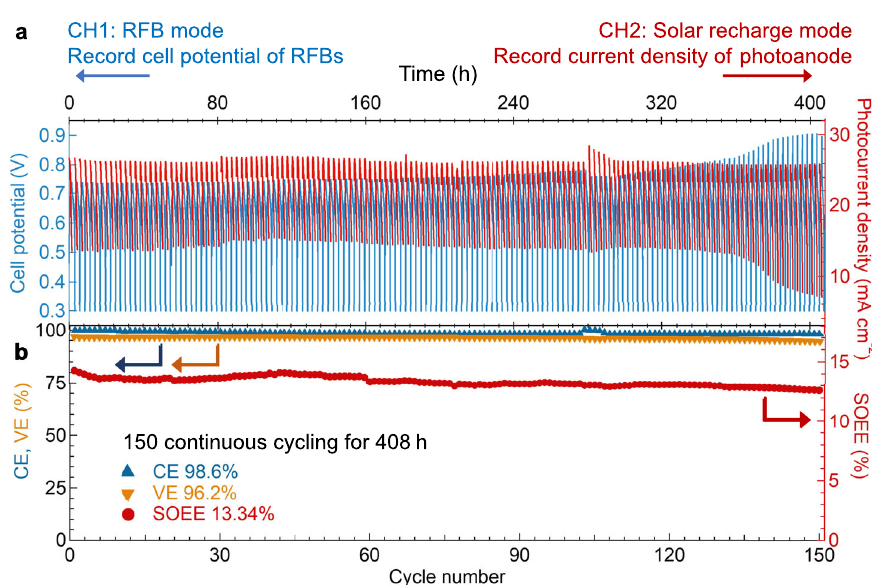
Fig. 4 SFB charging/discharging cycling performance. The SFB was integrated with SJ-GaAs photoanode and BTMAP-Vi/BTMAP-Fc redox couples. a Representative device cycling behavior showing the cell potential of SFB (blue curves), as well as the photocurrent density delivered by the GaAs photoanode (red curves). b Cycling ef fi ciency plots of the integrated SFB device showing CE (blue triangles), VE (orange triangles), and SOEE (red circles). The SFB cycling was performed under one Sun solar illumination over 150 cycles with 0.2 M BTMAP-Vi/Fc redox couples in catholyte/anolyte and a fl ow rate of 60 mL min − 1 . Each cycle started with 1.35 h of bias-free solar charging process followed by a galvanostatic discharging step at 11 mA until reaching the cutoff potential (0.3 V).